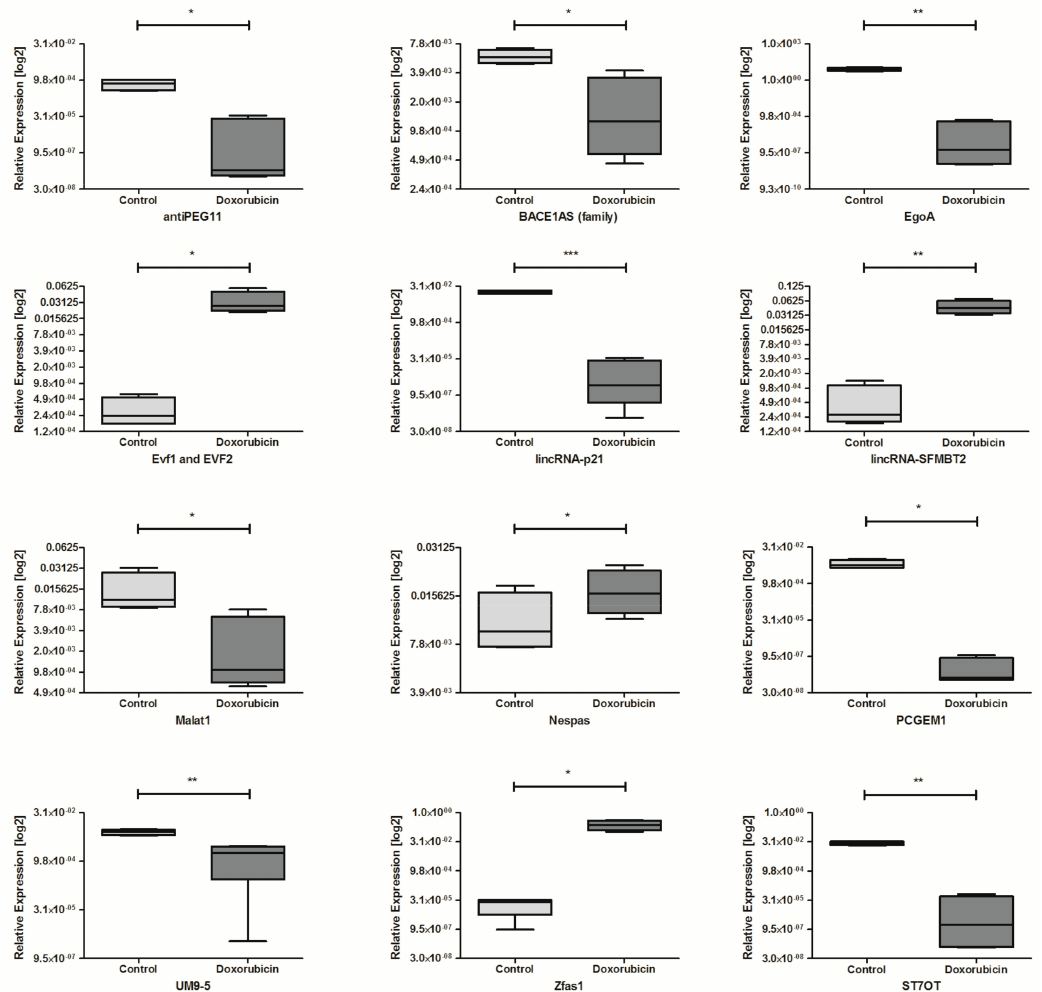
Figure 7. Differences in lncRNAs expression: antiPEG11, BACE1AS (family), EgoA, Evf1 and EVF2, lincRNA-p21, lincRNA-SFMBT2, Malat1, Nespas, PCGEM1, UM9-5, Zfas1, and ST7OT in HNSCC cell lines after exposure to doxorubicin and controls non-treated. Paired t -test; the graphs show relative expression, mean value with SEM; * p < 0.05, ** p < 0.01, *** p < 0.001. 3.3. Possible Regulation of Important Biological Processes and Cellular Pathways by Dysregulated lncRNAs In Silico The possible molecular interactions between dysregulated lncRNAs and specific genes after irradiation or chemoexposure were checked and analyzed in silico using PANTHER Classification System. Analysis of the available results indicated that lncRNAs may be involved in important biological processes and cellular pathways connected with direct response to irradiation and chemo exposure such as cell cycle, apoptosis, RAS pathway, and p53 pathway, with cell phenotype and cancer initiating cells such as cadherin, Wnt, TGF-beta, EGFR, and Notch signaling pathways as well as angiogenesis, Table